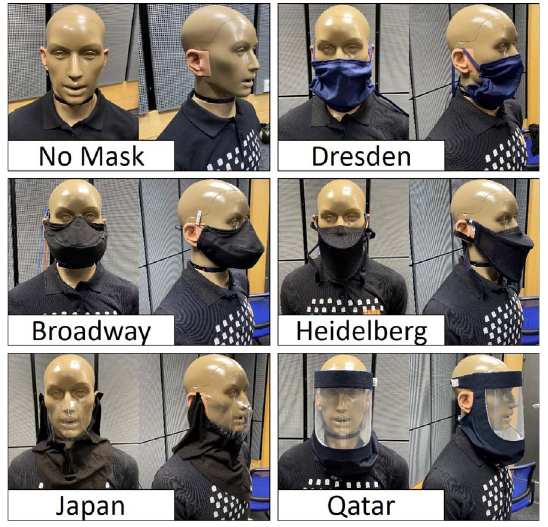
Figure 1. Five singeing masks in front and side view, worn by a KEMAR head for acoustic evaluation.